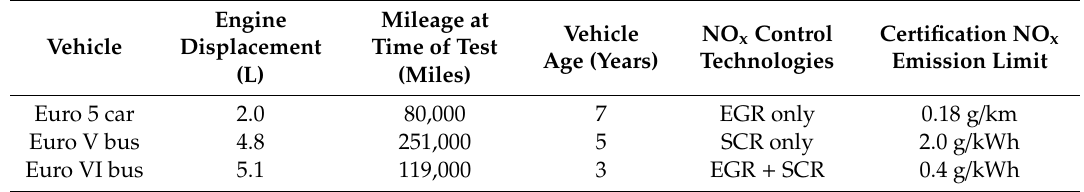
Table 1. Test vehicle specification